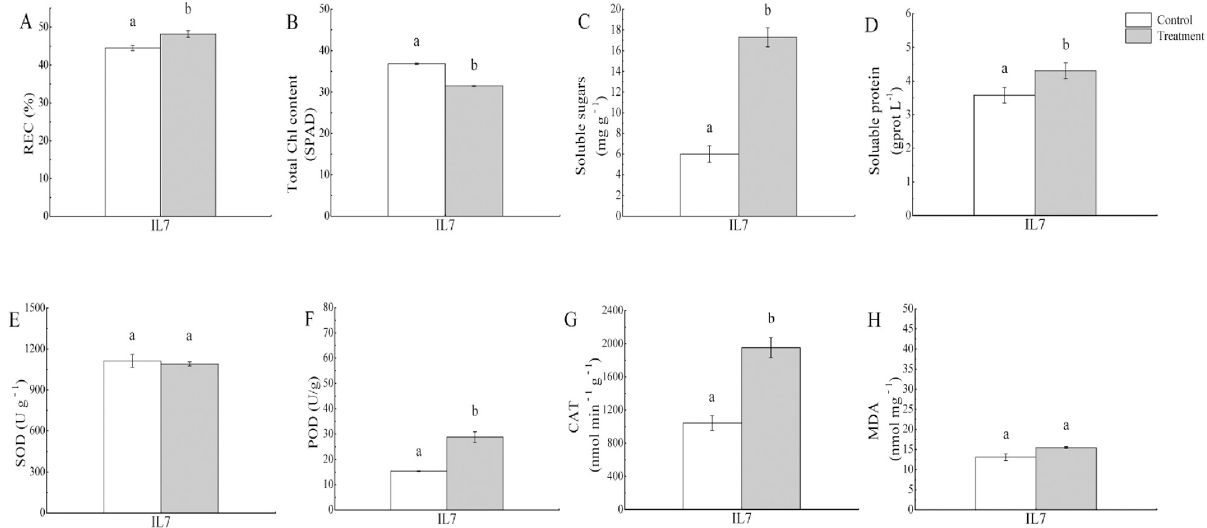
Fig 1. Physiological changes of IL7 under control and cold conditions. A, REC; B, SPAD index; C, Soluble sugar content; D, Soluble protein content; E, SOD; F, POD, G, CAT; H, MDA. Error bars denote standard error of the mean. Bars with the same small letters do not statistically differ by the Duncan’s multiple range test at P < 0.05.